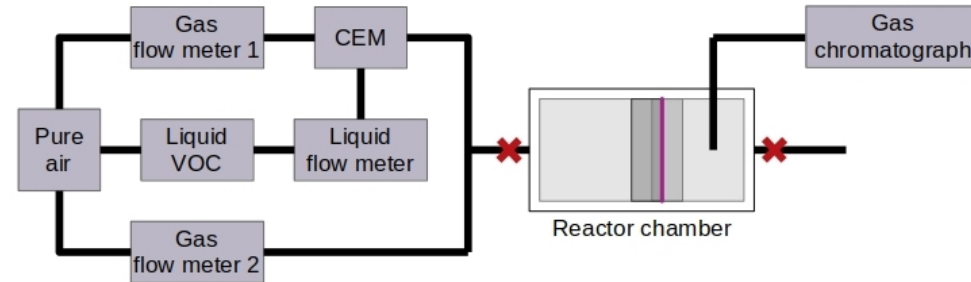
Figure 2. Liquid VOC contamination setup: The pure air cylinder supply for both the gas carriers and the bubbler device containing the VOC. A controlled evaporator and mixer (CEM) allow the liquid to evaporate and then mix with a line of pure air flow. The SDBD is located in the reactor, a parallelepiped with the size of 1.8 × 20 × 18cm 3 made by Delrin and with a cover in Plexiglas, inside which VOC depletion takes place. The volume of the free space used for the air treatment is about 0.5L. The gas chromatographic analysis was performed with a Micro GC Agilent 3000